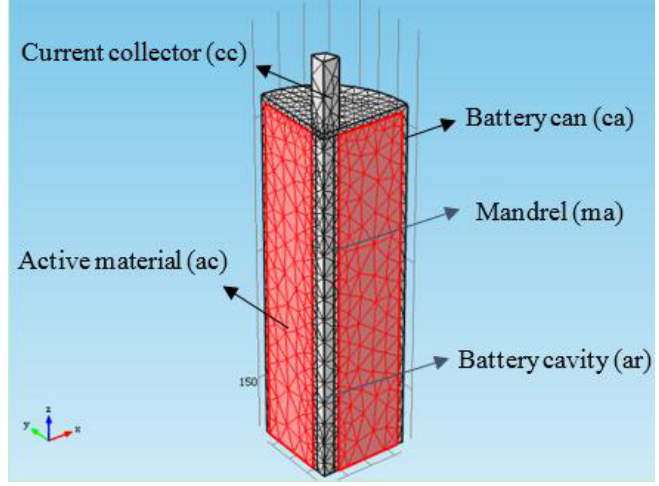
Figure 2. The 1/8 part geometric model used for the